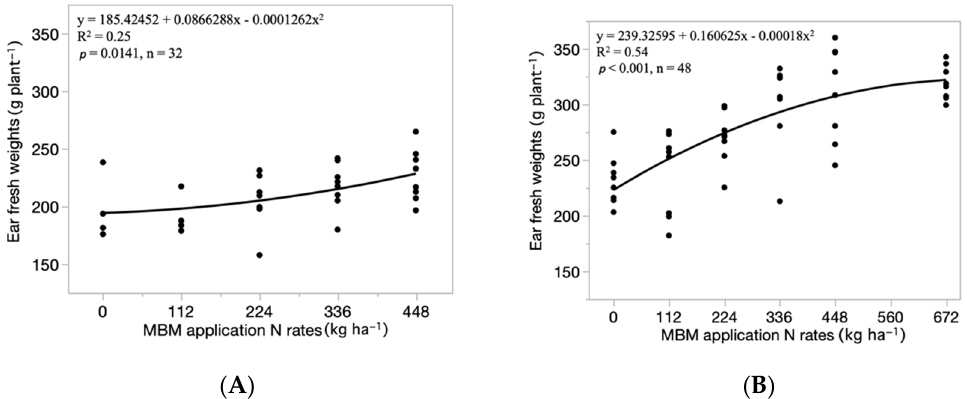
Figure 2. Regression analysis between meat and bone meal (MBM) application N rates and fresh weights, and of sweet corn ears at ( A ) Waimānalo and ( B ) Poamoho Research Stations.